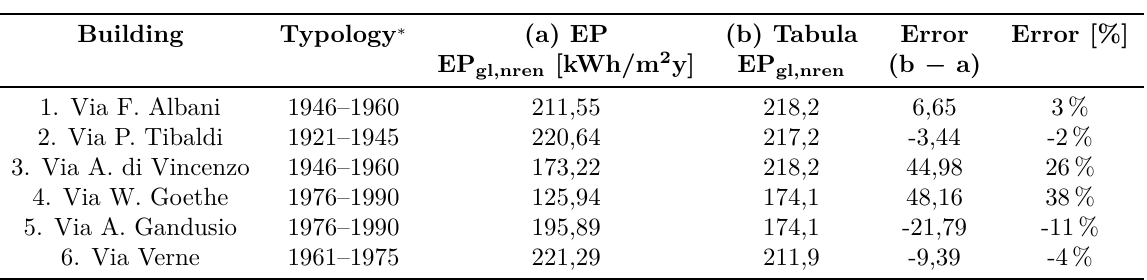
Table 1. Comparison of results from the validation